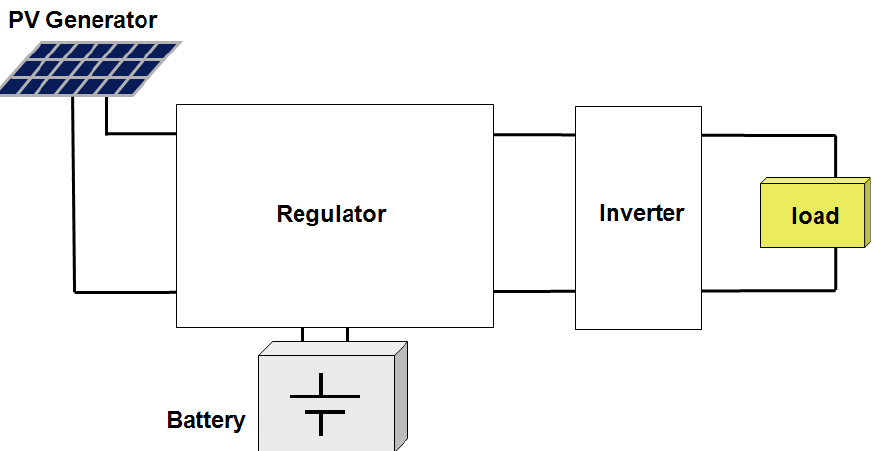
Figure 1. Structure of a typical stand ‐ alone PV system.